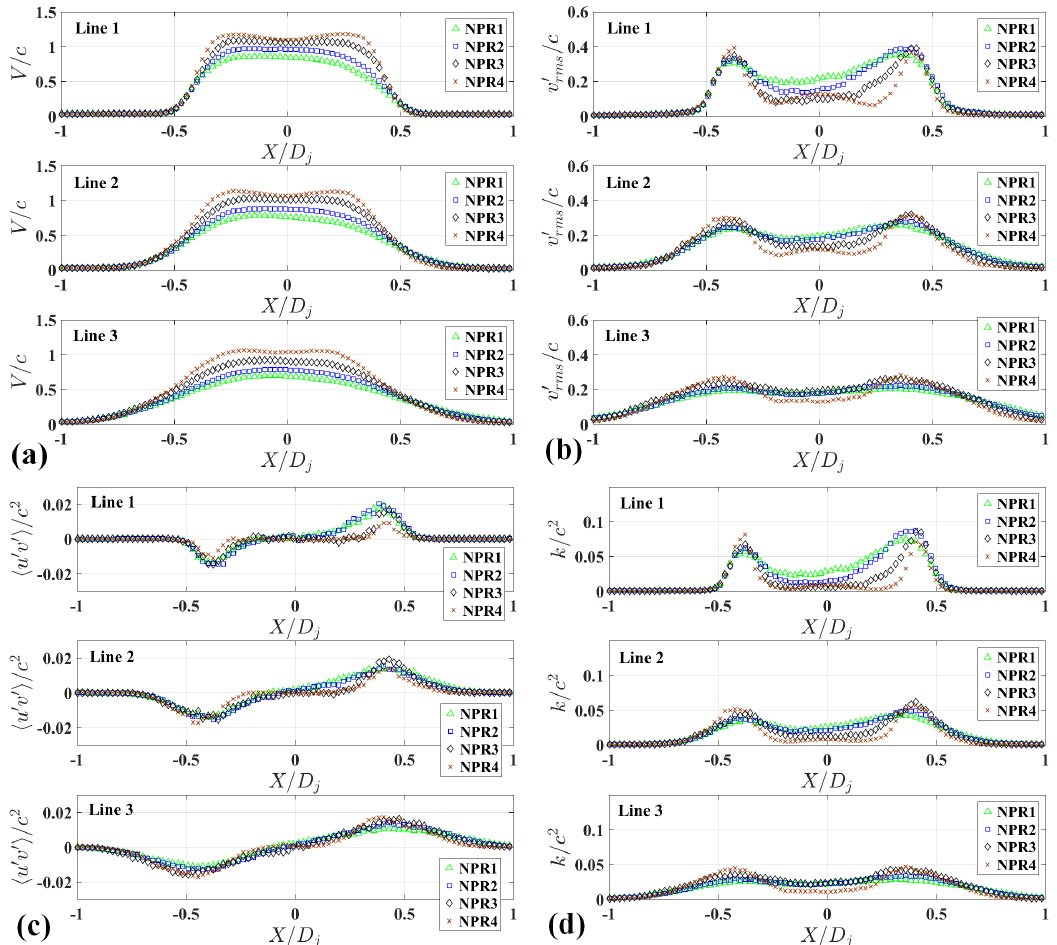
Figure 3. Comparisons of statistical results obtained from PIV measurements of under-expanded free jets for various values of NPRs, i.e., NPR 1 = 2, NPR 2 = 2.2, NPR 3 = 2.5, and NPR 4 = 2.77. Profiles were interpolated to Line 1 ( y = − 2.54) mm, Line 2 ( y = − 12.7) (mm), and Line 3 ( y = − 25.4) (mm). ( a ) Normalized mean axial velocity, V / c , ( b ) normalized RMS fluctuating axial velocity v (cid:48) rms / c , ( c ) normalized Reynolds stress (cid:104) u (cid:48) v (cid:48) (cid:105) / c 2 , and ( d ) normalized turbulent kinetic energy k / c 2